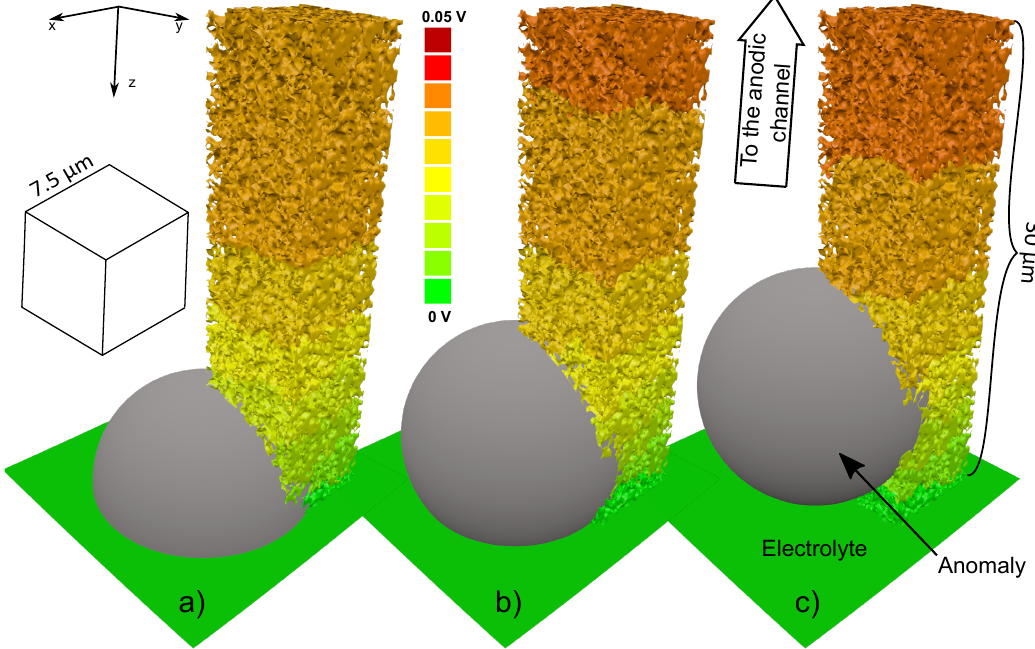
Figure 7. “Corner-type” non-conducting disturbance parametric study: 3D visualization of ionic potential and exchange current density fields for r = 7.5µm cases: ( a ) h = 0µm ( b ) h = 3.75µm ( c ) h = 7.5µm. Boundary conditions: φ el,b = 0.05 V, p H Thickness: 30.0µm. T = 1073